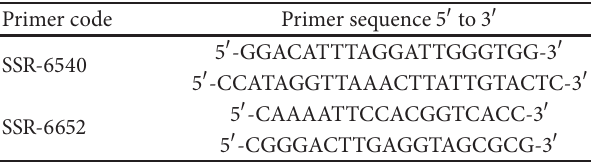
Table 2: Primer sequences used. Primer